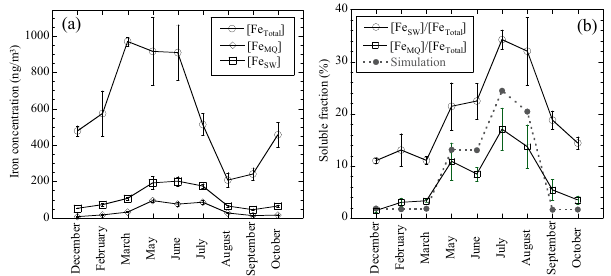
Fig. 10. (a) Concentrations of total Fe and Fe soluble in Milli-Q (MQ) water and simulated seawater (SW) noted as [Fe MQ ] and [Fe SW ], respectively. The values are tabulated in Table S2. (b) Sol- uble Fe fractions determined using the MQwater and SW extrac- tions, noted as [Fe MQ ]/[Fe Total ] and [Fe SW ]/[Fe Total ], respectively. Simulated results for [Fe SW ]/[Fe Total ] assuming the apparent sol- ubilities of ferrihydrite, illite, Fe(III) sulfate, and hornblende were also included. Error bars are standard deviations obtained by three independent experiments.